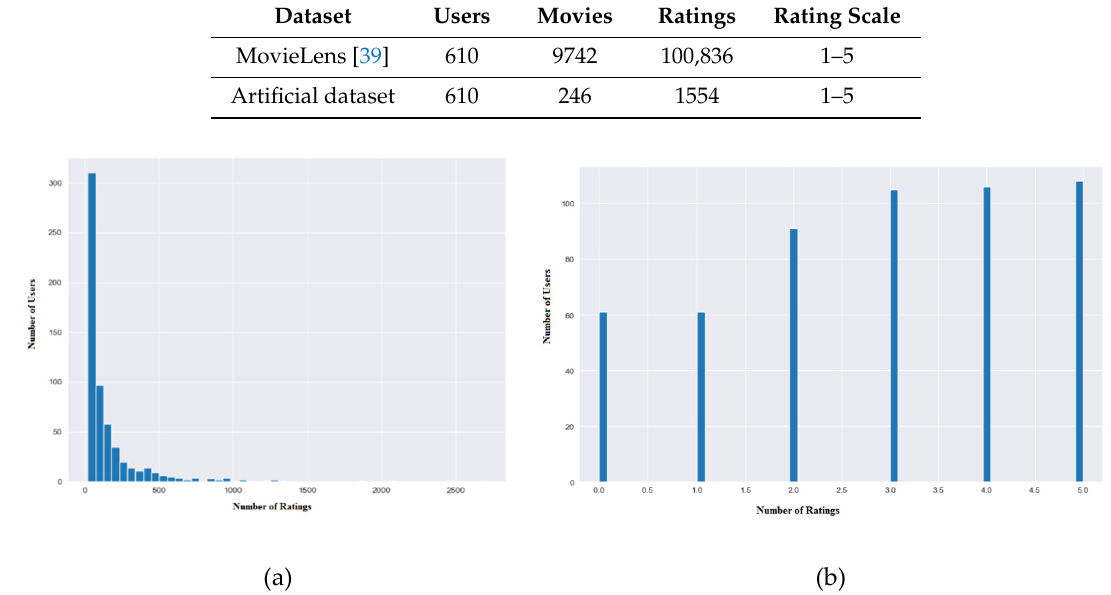
Figure 8. MovieLens and artificial datasets in terms of the number of cold start users and data sparsity: ( a ) MovieLens dataset of users who have rated at least 20 movies; ( b ) artificial dataset that includes 80% of users with 10% of their available ratings, 10% cold start users and 10% of users with a single rating.